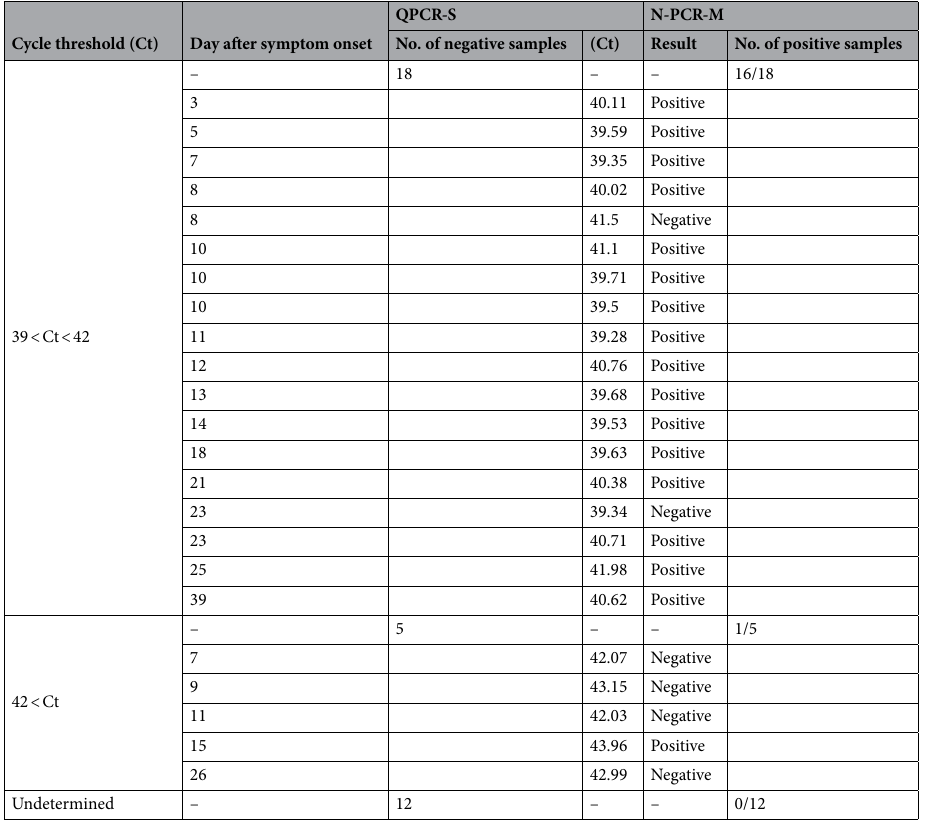
Table 2. Comparison of QPCR-S (real-time reverse transcription-RT polymerase chain reaction-PCR targeting the S-segment of the SFTS virus) negative samples (Ct > 42) with NPCR-M (RT nested PCR targeting the M-segment of the SFTS virus) results for blood samples tested from severe fever with thrombocytopenia syndrome (SFTS) patients in the